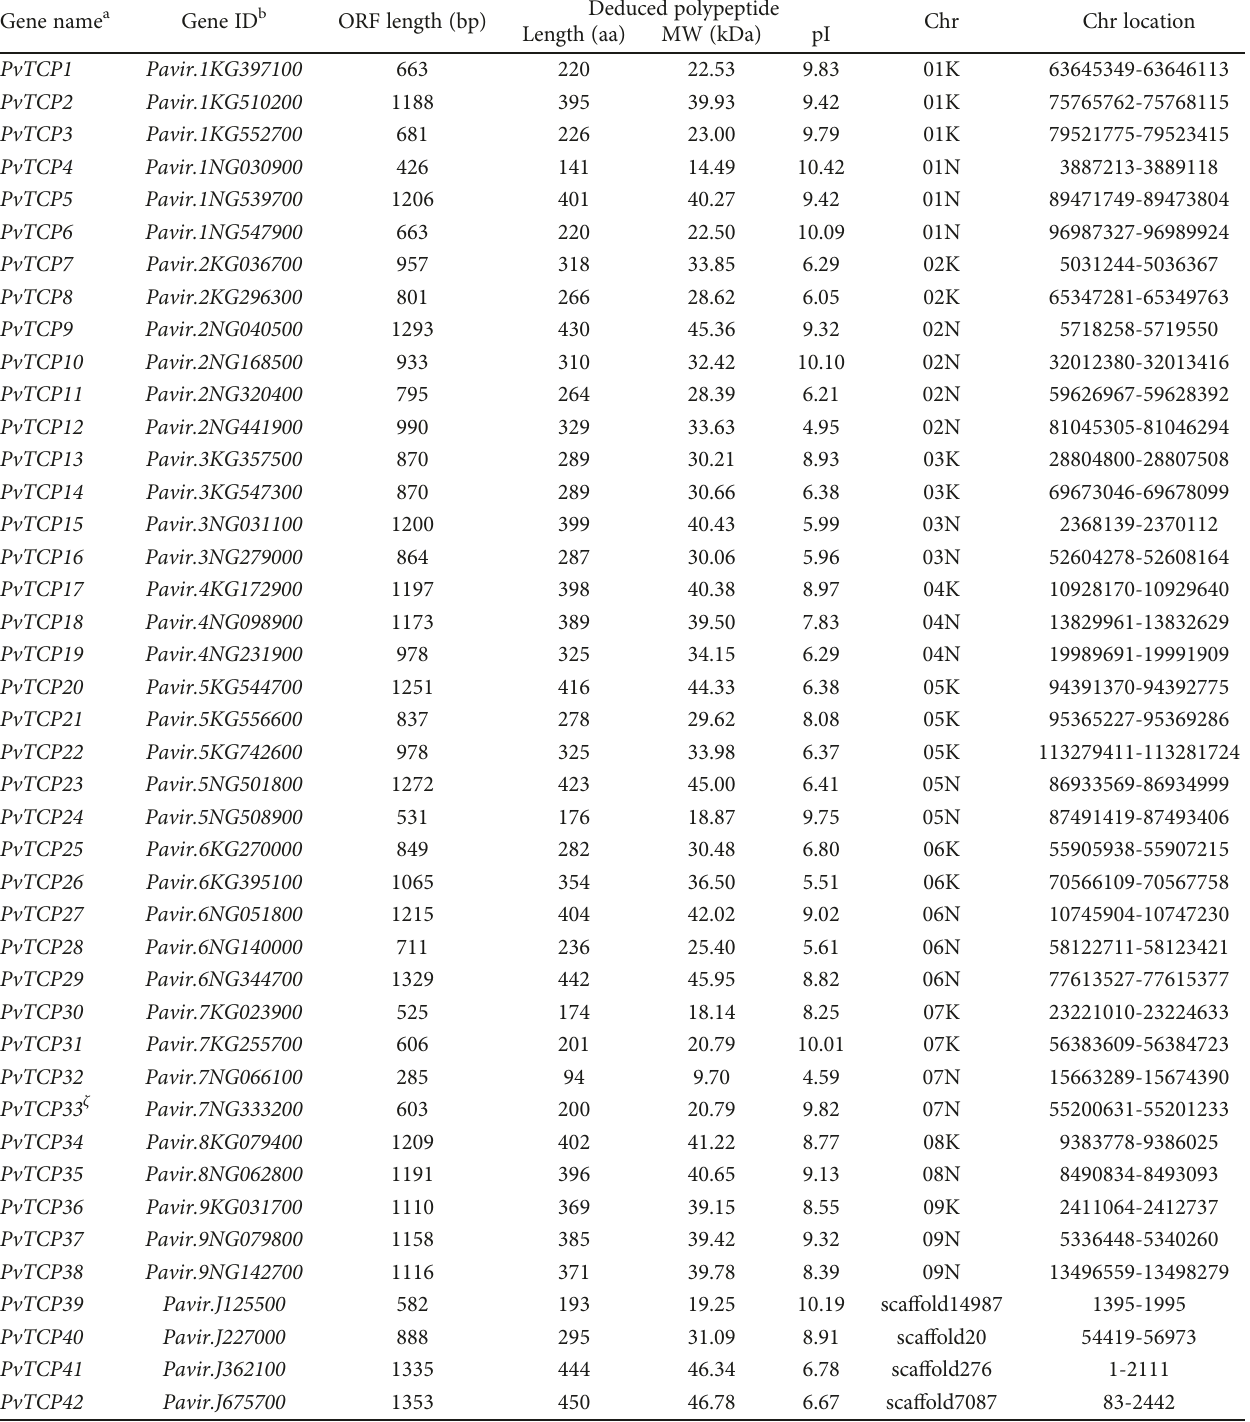
Table 1: Overview of TCP genes in